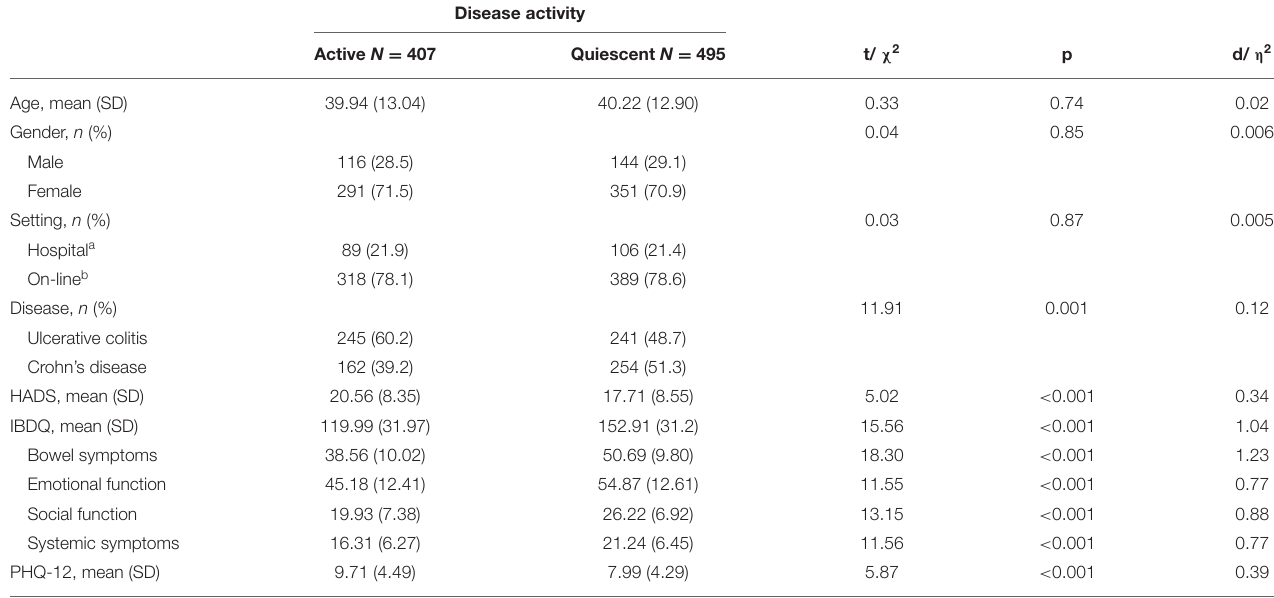
TABLE 1 | Sociodemographic and clinical characteristics of patients.